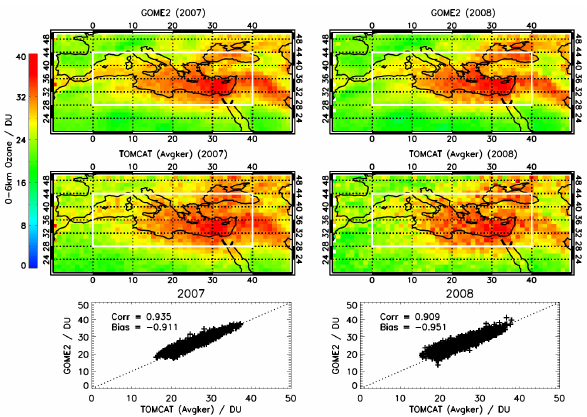
Fig. 3. Comparison of GOME-2 (top panels) and TOMCAT (middle panels) 0-6 km sub-column summertime ozone (DU) over the Mediterranean region for the years 2007 (left) and 2008 (right). The TOMCAT model output has been matched in time (within 6 hours) and space to each GOME-2 observation and the GOME-2 averaging kernels have been applied before both sets of data have then been averaged over the months of June, July and August. The bottom panels show the correlation between the model and satellite observations for points within the white box shown in the top four panels.